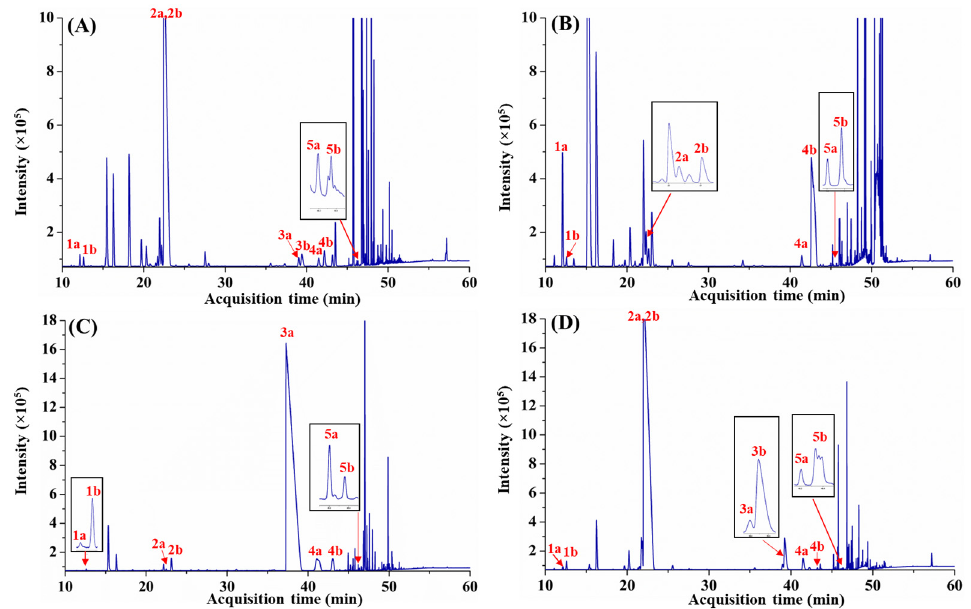
Figure 2. Enantioanalysis of selected chiral monoterpenes in four Citrus spp. leaf EOs using eGC–FID. ( A ), C. limon ; ( B ), C. microcarpa ; ( C ), C. hystrix ; and ( D ), C. pyriformis . 1a, ( − ) ‐α‐ pinene; 1b, (+) ‐α‐ pinene; 2a, ( − ) ‐ limonene; 2b, (+) ‐ limonene; 3a, ( − ) ‐ citronellal; 3b, (+) ‐ citronellal; 4a, ( − ) ‐ linalool; 4b, (+) ‐ linalool; 5a, (+) ‐ terpinen ‐ 4 ‐ ol; and (5b), ( − ) ‐ terpinen ‐ 4 ‐ ol.